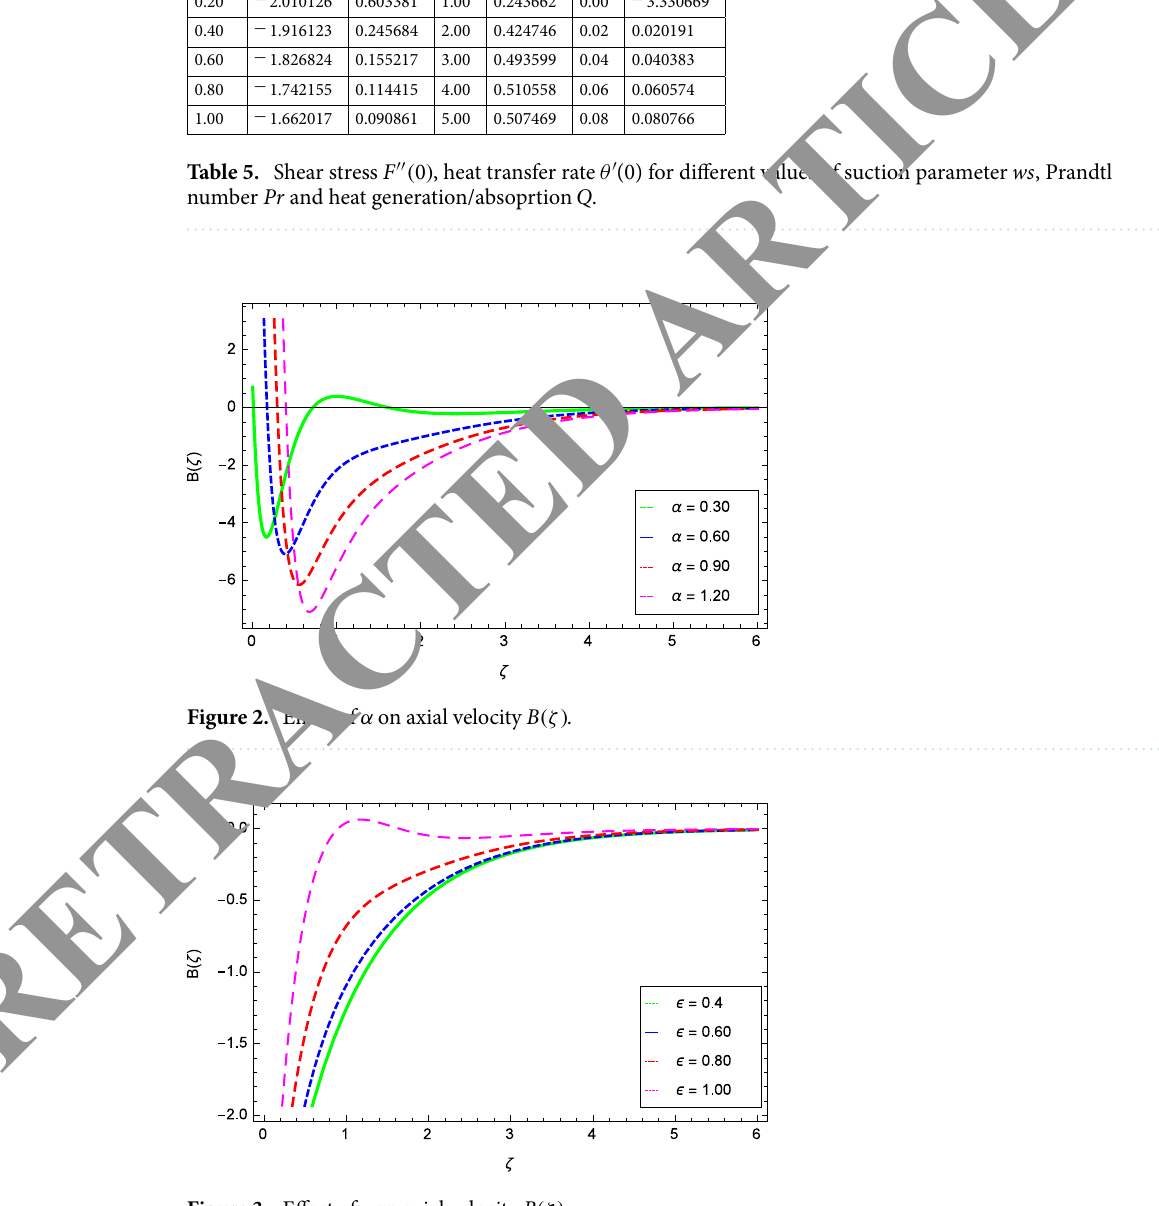
Figure 3. Effect of ǫ on axial velocity B (ζ)